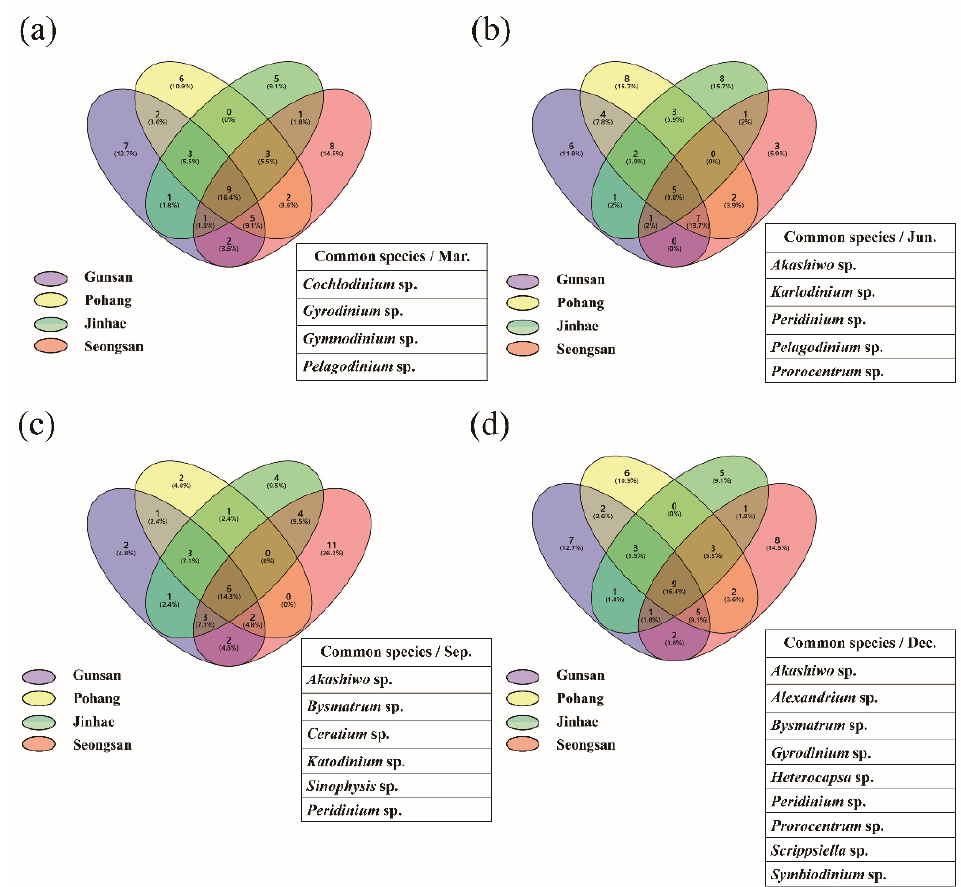
Figure 4. Seasonal common dinoflagellate species in 4 coastal waters by metagenome analysis. March ( a ), June ( b ), September ( c ), and December ( d ).